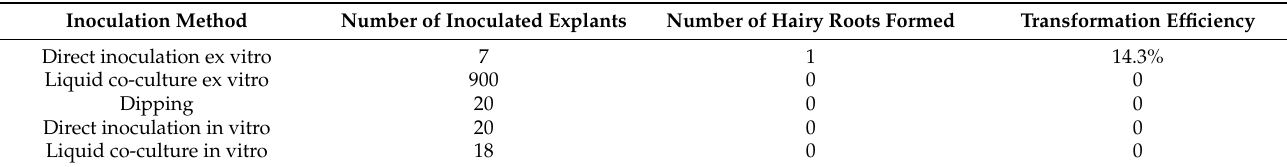
Table 2. Transformation efficiency of different inoculation